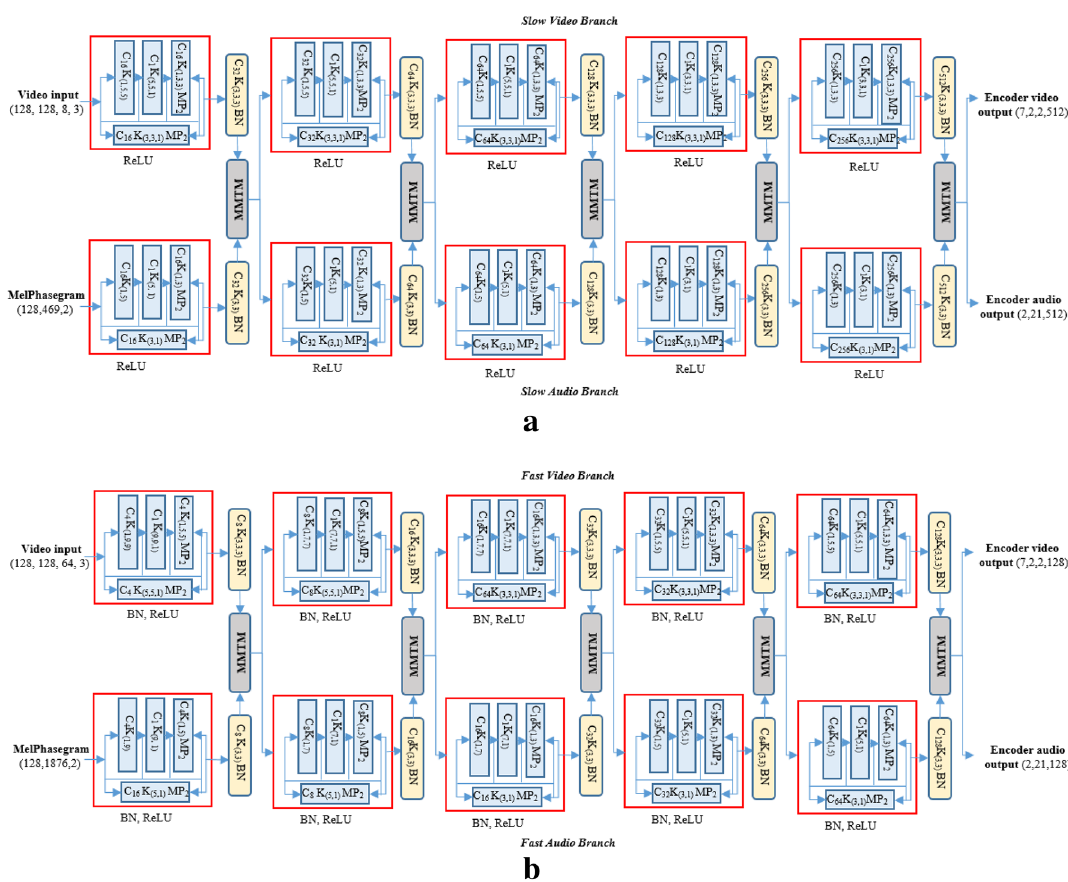
Figure 5. ( a ) Slow branch of the separable slow–fast music video network. ( b ) Fast branch of the separable slow–fast music video